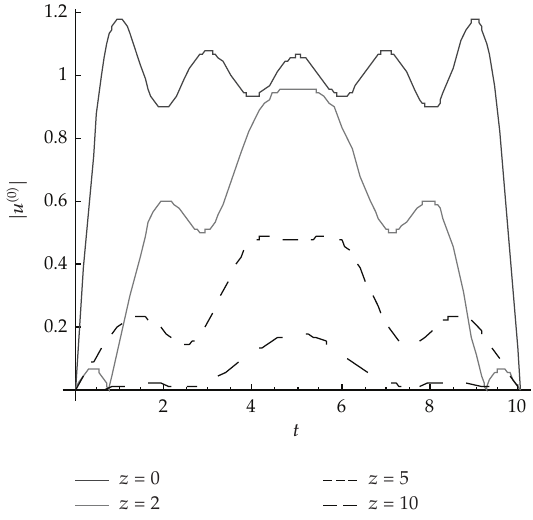
Figure 5: The zero-order approximation | u (cid:3) 0 (cid:4) | at α (cid:8) 1, T (cid:8) 10, γ (cid:8) 02 for di ff erent values of z , considering only one term in the series (cid:3) M (cid:8) 1 (cid:4) .